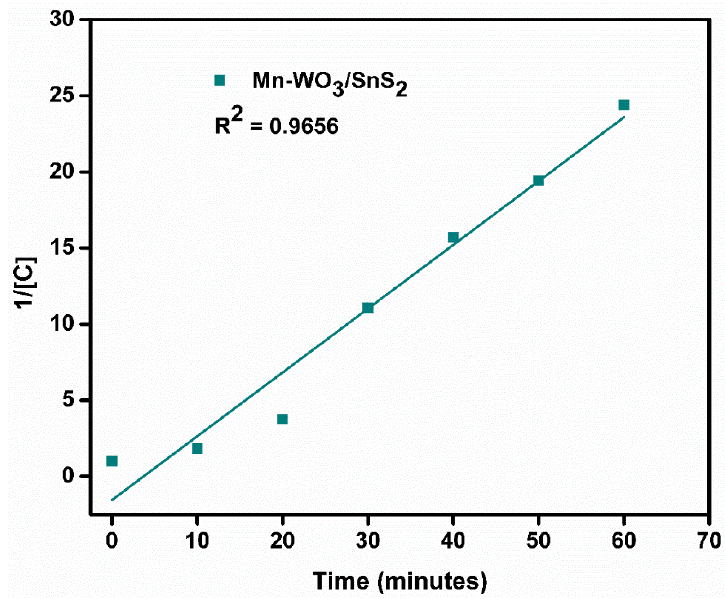
Figure 12. Photodegradation kinetics for chlorpyrifos using Mn-WO 3 / SnS 2